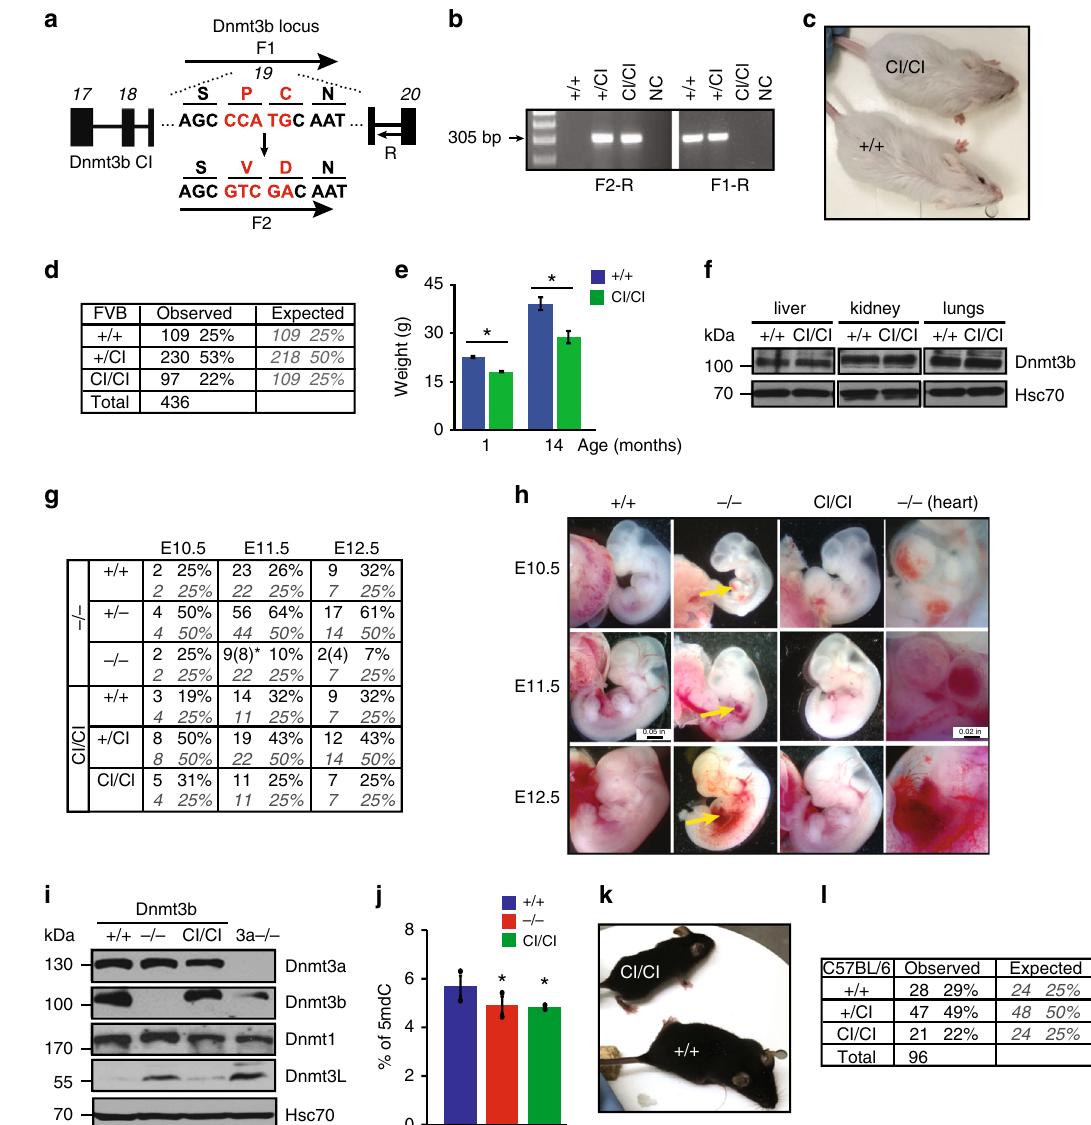
Fig. 1 Catalytically inactive Dnmt3b is suf fi cient for normal mouse embryogenesis. a The schematic illustrates exons 17 – 20 (black boxes) of the mouse Dnmt3b , a portion with nucleotide and amino acid sequences in exon 19 encoding wild type (top) and sequence encoding amino acid substitution: PC to VD inactivating catalytic activity that was used to generate Dnmt3b CI allele (bottom). Position of genotyping primers is indicated by arrows. F1-R detects wild-type sequence; F2-R detects mutated sequence. b PCR genotyping assay performed on DNA isolated from Dnmt3b + / + ( + / + ), Dnmt3b + /CI ( + /CI) and Dnmt3b CI/CI (CI/CI) mice. F1-R and F2-R represents primer pairs detecting wild type and CI allele, respectively. NC, no template control. c Micrograph of 6-week-old + / + and CI/CI mice. d Genotypic analysis of offspring derived from Dnmt3b + /CI intercrosses (FVB strain). e The weight of Dnmt3b + / + ( + / + ) and Dnmt3b CI/CI (CI/ CI) mice measured at 1 ( n = 16) and 14 months ( n = 4). Data are presented as mean±SEM, * p <0.001 (two-tailed Student ’ s t -test). f Immunoblot showing Dnmt3b protein levels in liver, kidney, and lungs of 8 weeks old + / + and CI/CI mice. Hsc70 served as a loading control. g Genotypic analysis of embryos isolated from intercrosses of Dnmt3b + / − and Dnmt3b + /CI mice at E10.5, E11.5, and E12.5. Bold font indicates observed numbers and gray italic indicates expected number. Numbers in brackets denote dead embryos. * p <0.01 ( χ 2 -test). h Gross morphology of Dnmt3b + / + , Dnmt3b − / − and Dnmt3b CI/CI E10.5, E11.5, and E12.5 embryos (magni fi cation ×8). Arrows point to hemorrhages and pericard edema of Dnmt3b − / − mice. Higher-magni fi cation (×40) images of hearts are shown in the right panel. i Immunoblot showing Dnmt3a, Dnmt3b, Dnmt1, Dnmt3L, and Hsc70 (loading control) protein levels in E11.5 Dnmt3b + / + ( + / + ), Dnmt3b − / − ( − / − ), Dnmt3b CI/CI (CI/CI), and Dnmt3a − / − (3a − / − ) whole embryo lysates. This labeling of genetic groups is used in all subsequent fi gures unless noted otherwise. j Percentage of methylated cytosines in genomic DNA in Dnmt3b + / + ( + / + ), Dnmt3b − / − ( − / − ), Dnmt3b CI/CI (CI/CI) E11.5 embryos ( n = 2) as determined by mass spectrometry. Data are presented as mean ±SEM. * p <0.05 (two-tailed Student ’ s t -test). k Micrograph of 6-week- old + / + and CI/CI mice (C57BL/6 strain). l Genotypic analysis of offspring derived from intercrosses of Dnmt3b + /CI mice (C57BL/6 background). Source data are provided as a Source Data fi